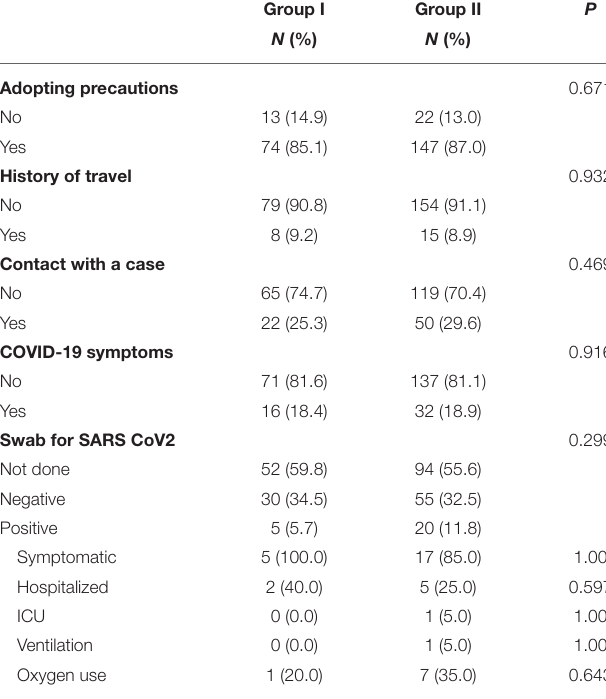
TABLE 3 | COVID-19 risk factors, symptoms and their severity, and PCR results.